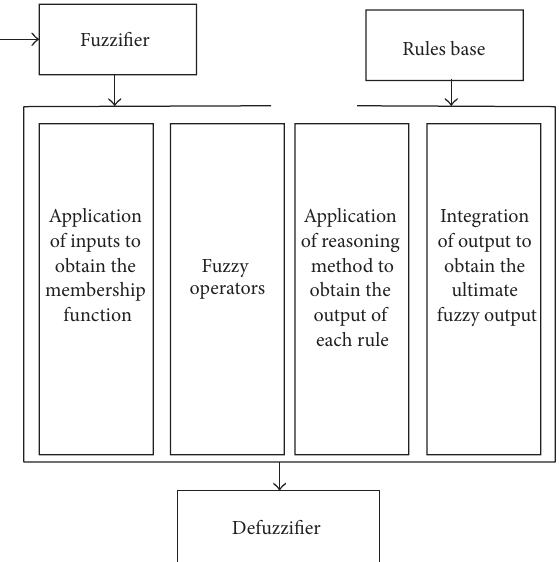
Figure 1: A fuzzy inference system for environmental risk analysis of each project.